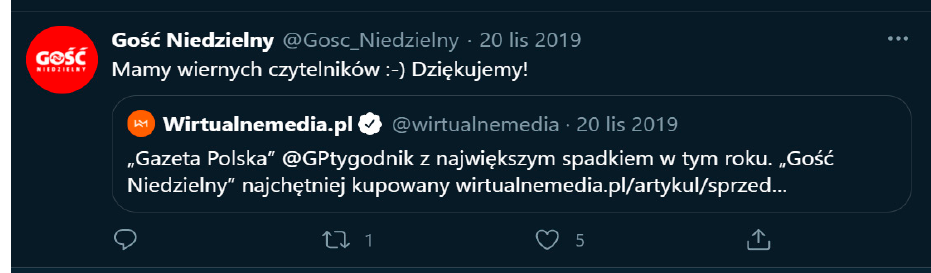
Figure 6. A self-promotional tweet by Go ść Niedzielny , 20.11.2019. Source: Twitter/screenshot.